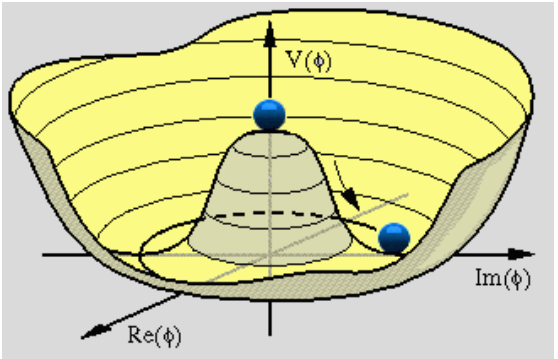
Figure 2. Explanation of the Brout–Englert–Higgs (BEH) mechanism. The axial symmetry of the Mexican hat is not violated by a ball placed on its top, but it will be spontaneously broken when the ball rolls down in the valley. Because of the axial symmetry of the potential, we can rotate the coordinate system so that the ball will be at the point Im ( Φ ) =